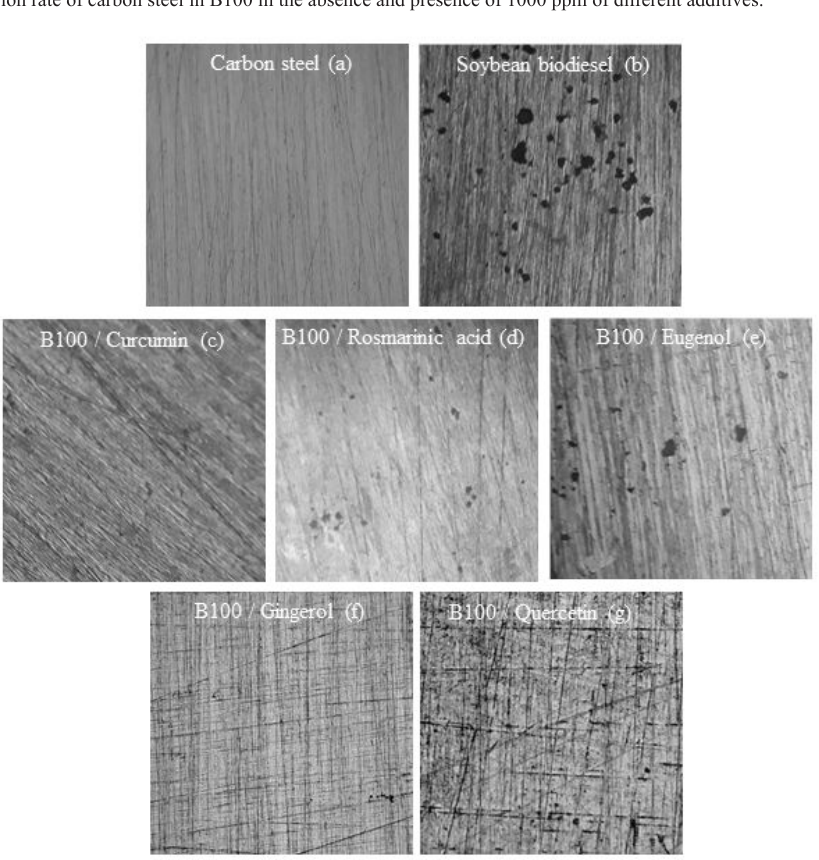
Figure 5. Appearances of carbon steel coupons observed by light microscopy after immersion in B100 in the absence and presence of various